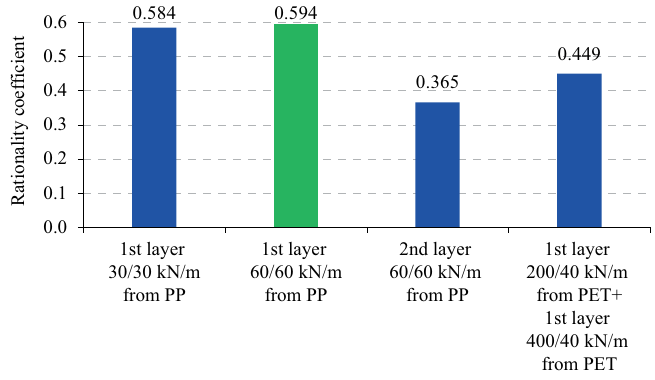
Figure 13. Rationality coefficients for geogrid structure